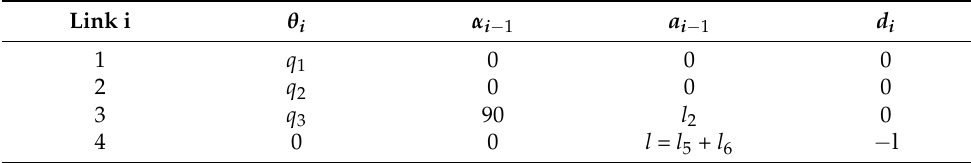
Table 1. D-H parameters of walking